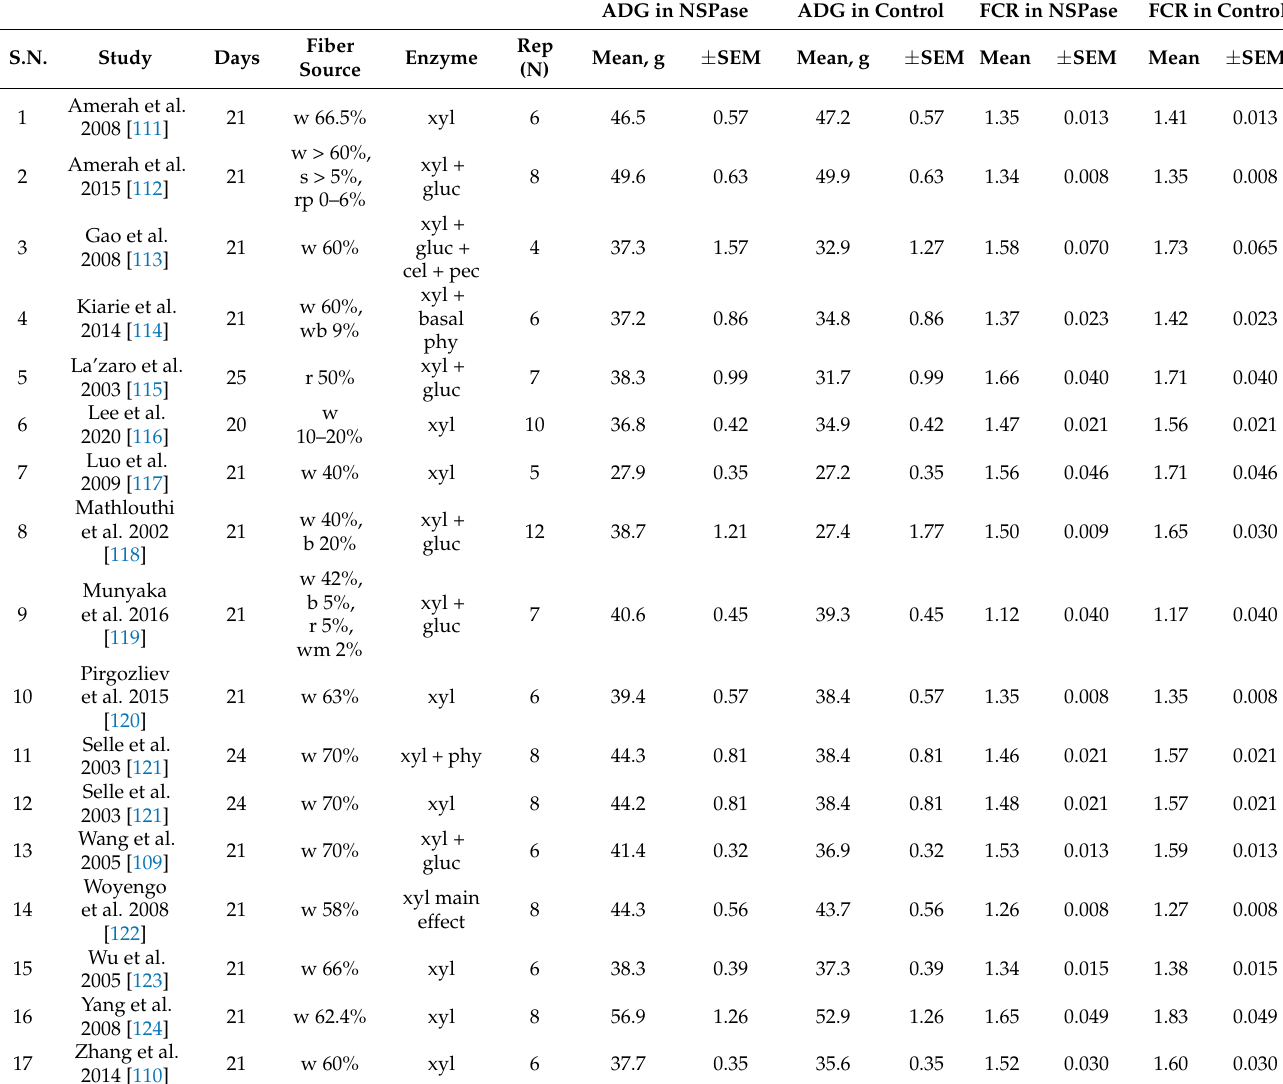
Table 1. Fiber source, enzyme combination, and summary statistics of research outcomes of selected research papers evaluating the effects of non-starch polysaccharides-degrading enzymes on average daily gain and feed conversion ratio in broilers. ADG in NSPase ADG in Control FCR in NSPase FCR in Control